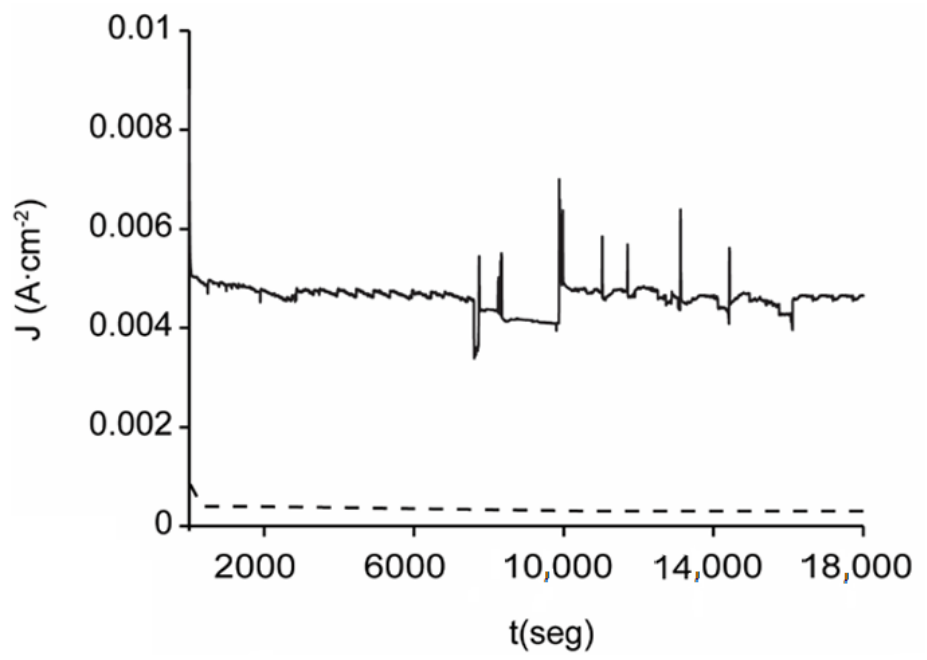
Figure 17. Electrolysis at constant potential of doped EBHSS, E λ+ = 1 V vs. SSE of direct current at pH = 2 and 25 °C. Full line indicates doped EBHSS; dashed line, pure EBHS.